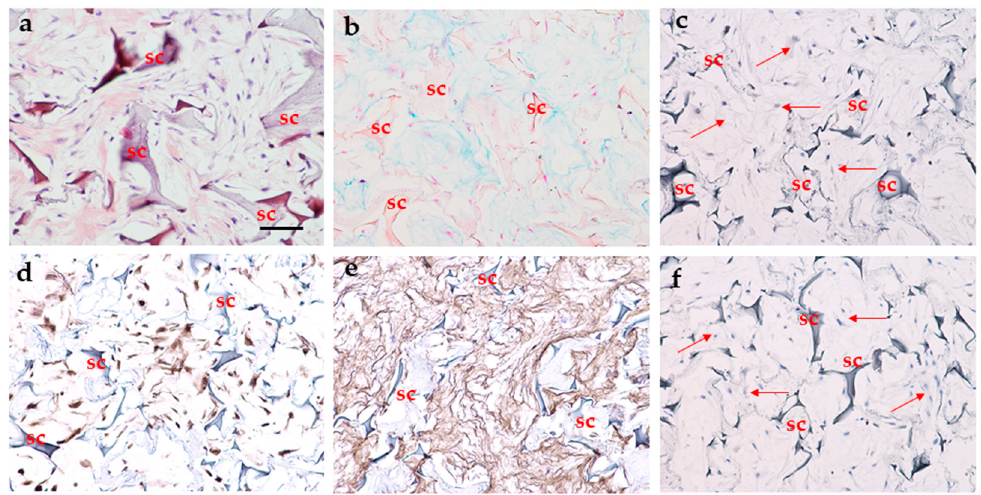
Figure 6. Histological analysis of the 3D fibrocartilage model. ( a ) H & E staining: cell nuclei are in blue-violet, cytoplasm is in pink; ( b ) Alcian blue pH1 staining: sulphated GAGs are in cyan, cell nuclei are in red; ( c – f ) IHC analysis for: ( c ) aggrecan ( d ) Sox-9, ( e ) collagen type I, ( f ) collagen type II. Antigen expression is revealed in brown, cell nuclei are in blue-violet. Sc = scaffold; red arrows = cells. ( b – f ) Scale bar = 100 μ m. Original magnification 200×.